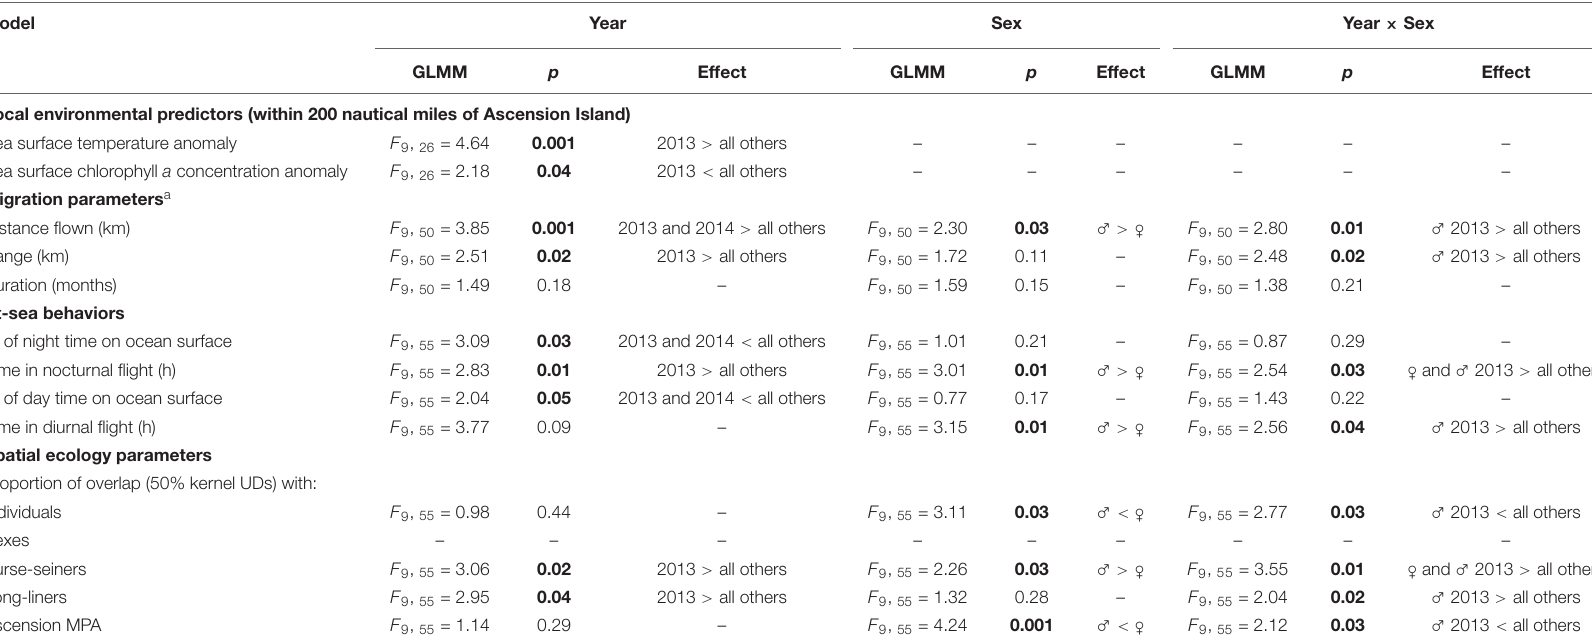
TABLE 2 | Generalized linear mixed models (GLMMs) testing the effect of year (2011–2015), sex and the year × sex interaction on the local environmental predictors within the Ascension MPA, migration parameters, at-sea behaviors and spatial ecology parameters of sooty terns, as detailed in Table 1 .